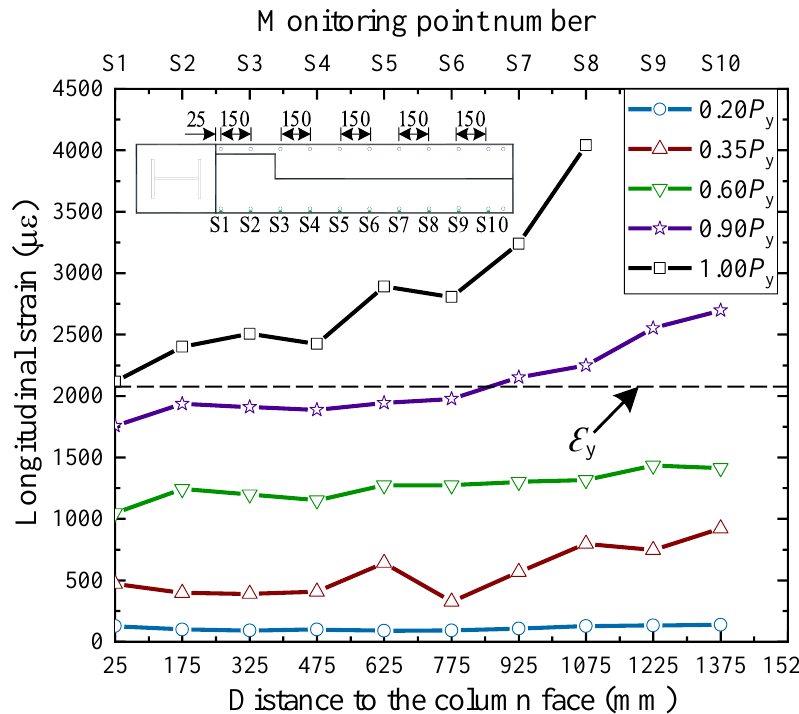
Figure 12. Strain distribution along the sidewall cross-section.